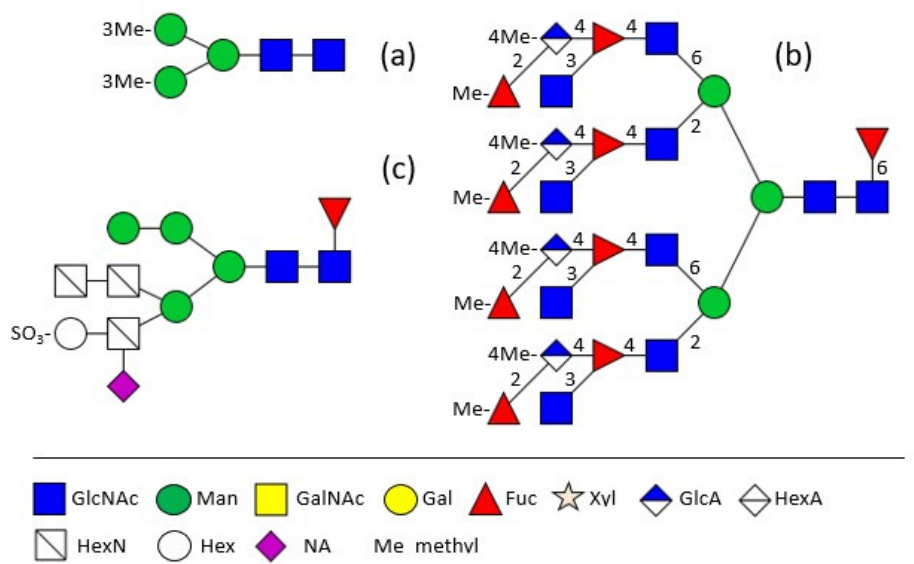
Figure 1. Shell matrix protein N-glycans of ( a ) Biomphalaria glabrata [15]; ( b ) Mytilus edulis [16]; ( c ) Pincatada fucata [17]. The structure plots were generated in the notation of the Consortium for Functional Glycomics (http://www.functionalglycomics.org, accessed on 16 November 2021). All figures were drawn especially for this review, based on previously published data as